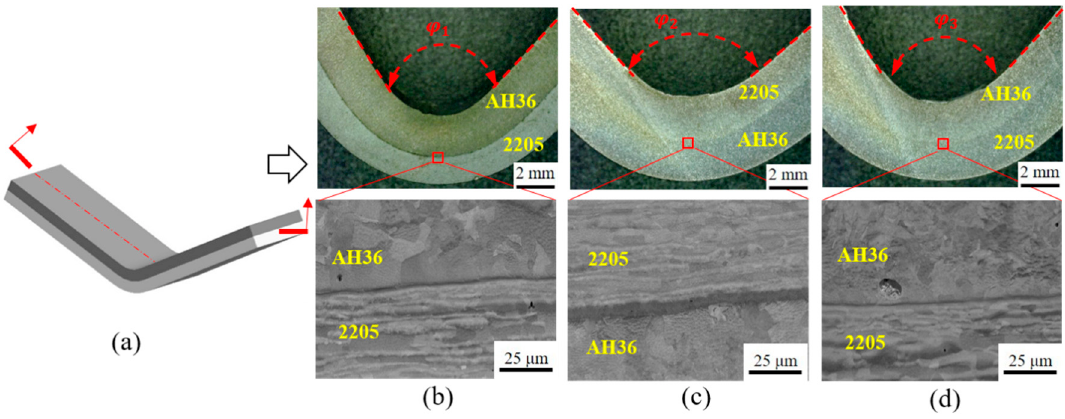
Figure 9. ( a) The bent model of 2205 / AH36 BC, and the SEM morphology of the bent mid-section, ( b ) at 950 °C with the outside 2205 steel layer, ( c ) at 950 °C with the inside 2205 steel layer and ( d ) at 1050 °C with the outside 2205 steel layer.